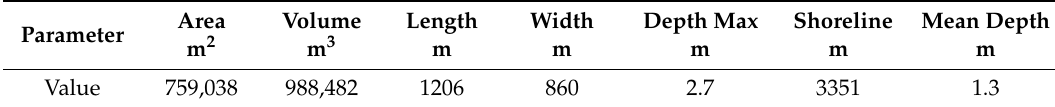
Table 1. Selected morphometric characteristic of Lake